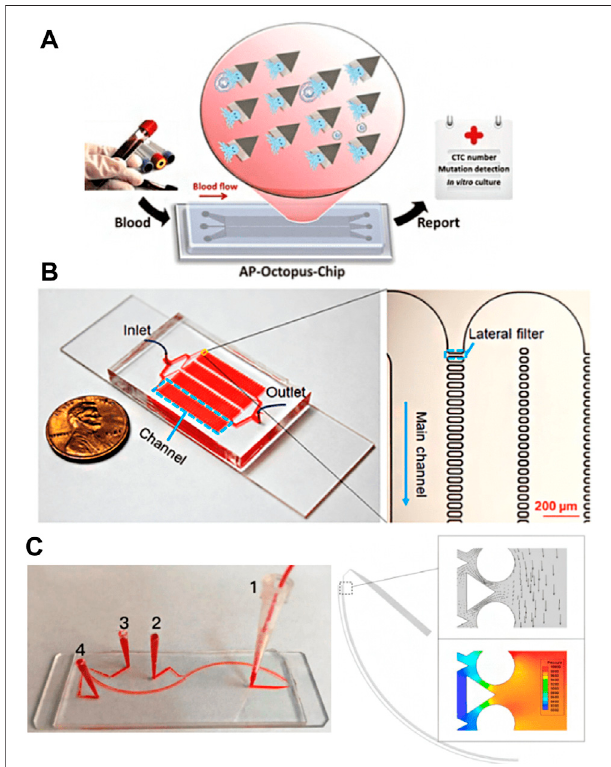
FIGURE 5 | CTCs Enrichment by combining biological af fi nity with physical screening (A) The Octopus chip for cell capture (Song et al., 2019); (B) The LFAM device consisting of four serpentine main channels (Chen et al., 2019); (C) The antibody functional microsphere integrated fi lter chip (Su et al.,